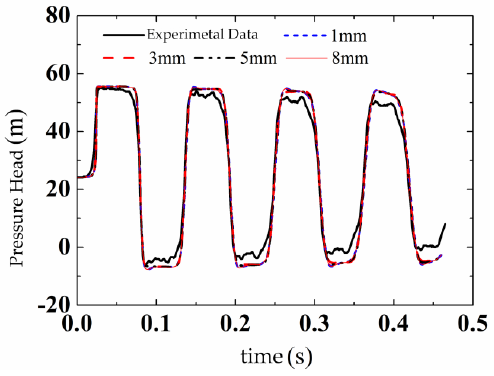
Figure 4. Comparison of the cross-sectional average pressure fluctuations at the S 3 position in different grids.